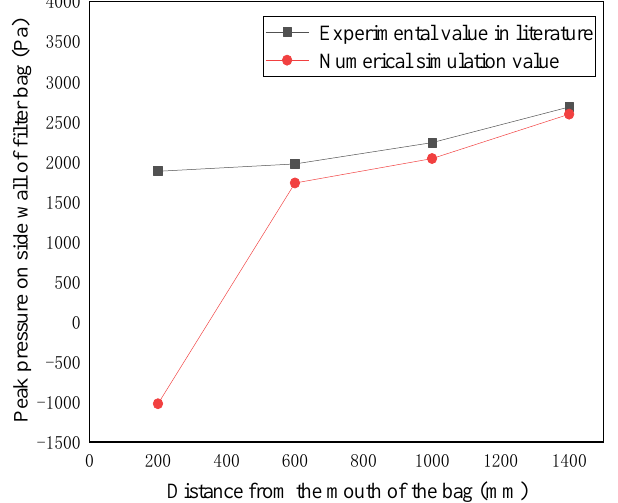
Figure 2. Comparison of the literature experimental value and numerical simulation value of the side wall pressure peak of the filter bag.